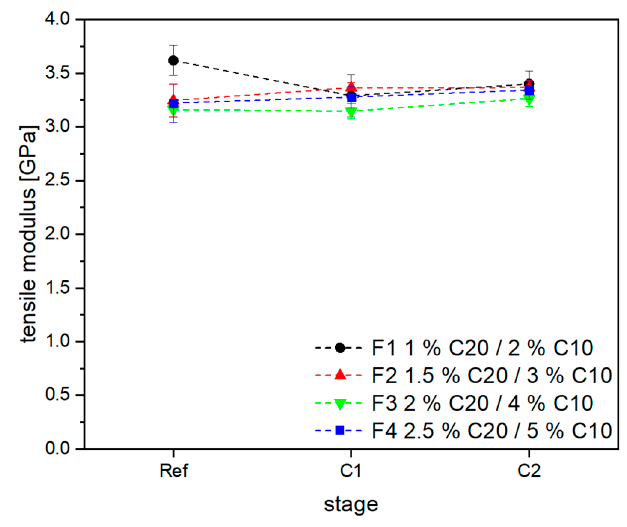
Figure 16. Tensile modulus of neat samples of the four formulations F1–F4.